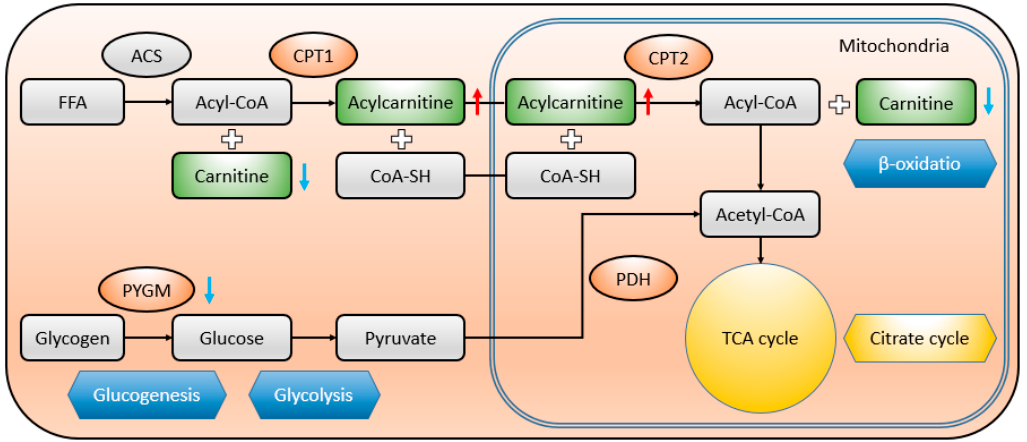
Figure 7. Schematic overview of some important metabolites and major metabolic pathways related to fatty acid (adapted from KEGG ID ssc04931) and carbohydrate metabolism (adapted from KEGG ID ssc04922) in heat-stressed pigs. FFA, free fatty acid, here are mainly long-chain fatty acids (C10-C18). ACS, long-chain acyl-CoA synthetase; CPT1, carnitine O-palmitoyltransferase 1; CPT2, carnitine O-palmitoyltransferase 2; PYGM, muscle glycogen phosphorylase; PDH, pyruvate dehydrogenase, Red up-arrow, heat stress (HS) group vs CR. Blue down-arrow, HS group vs CR.